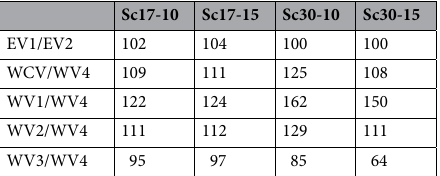
Table 6. The average speed ratio in corridor vents to other vents.